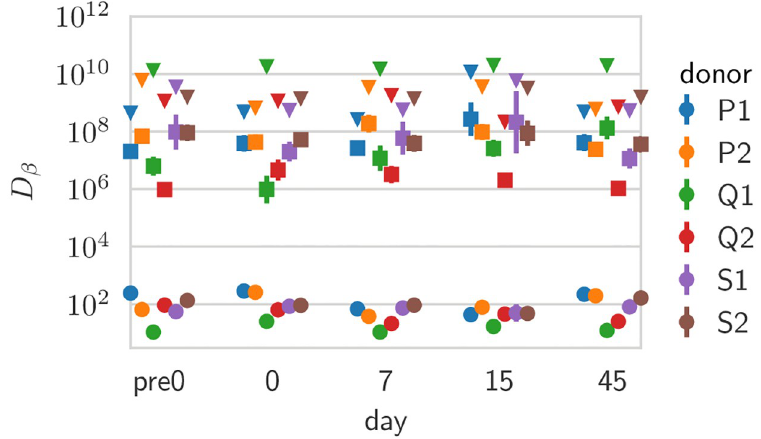
Fig 5. Diversity estimates. Shown are diversity estimates obtained from the Hill diversities, D β , of the inferred clone frequency distributions for β = 0 (estimated total number of clones, N ), β = 1 (Shannon entropy) and β = 2 (Simpson index), across donors and days. Error bars reflect parameter uncertainty in the inference, and are computed from the posterior distribution using a Gaussian approximation (error bars smaller than symbols not visible).